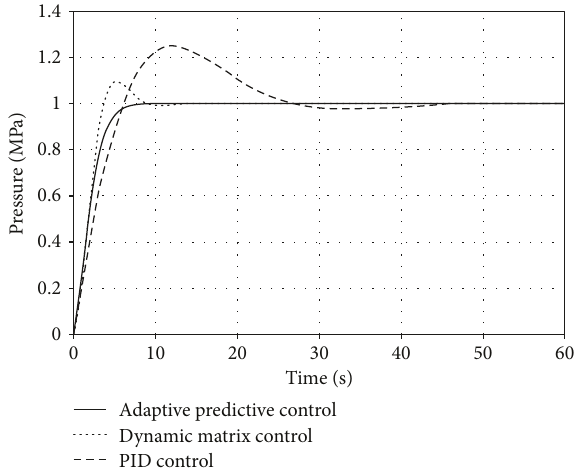
Figure 10: Response curves with di ff erent systems under 100% operating condition.